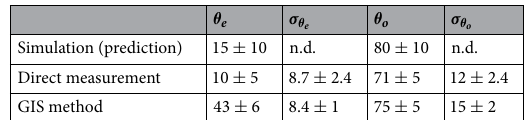
Table 1. Results on the angle (in degrees) measurements and